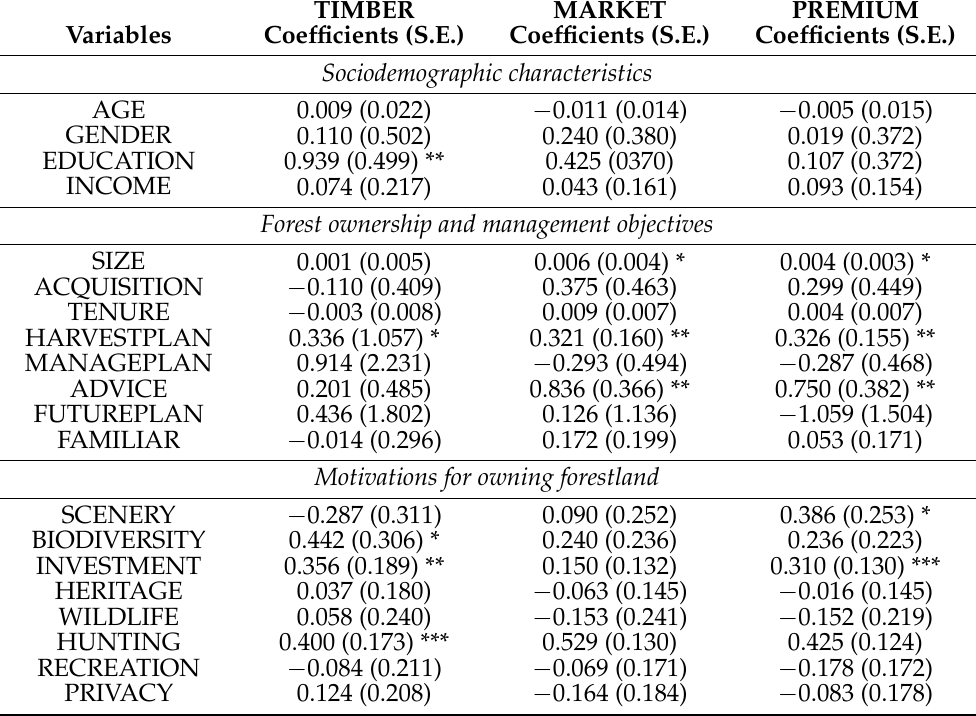
Table 4. Regression estimates of the empirical models for private landowners’ attitudes toward potential benefits of TIMBER, MARKET, and PREMIUM related to forest certification (n =